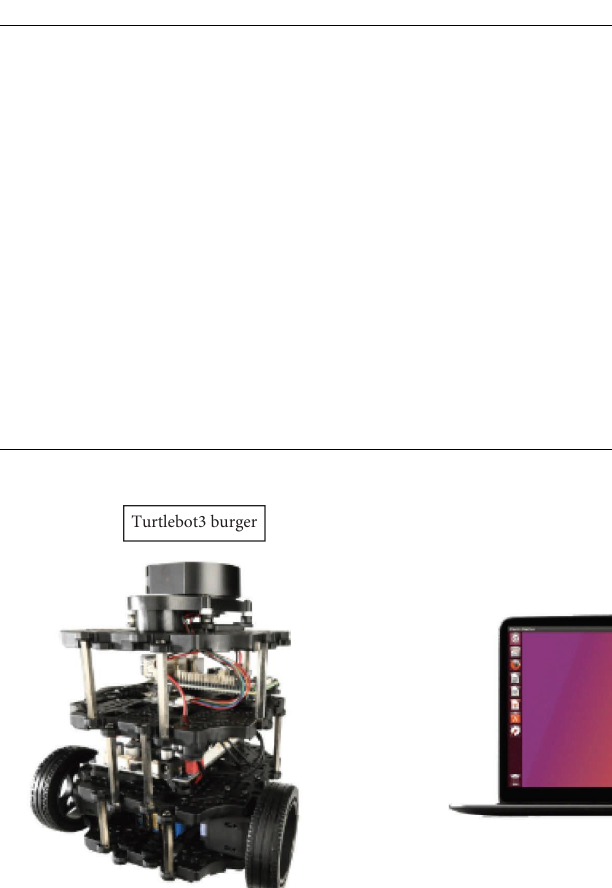
Table 4: Tuning guide for navigation in Figure 14.